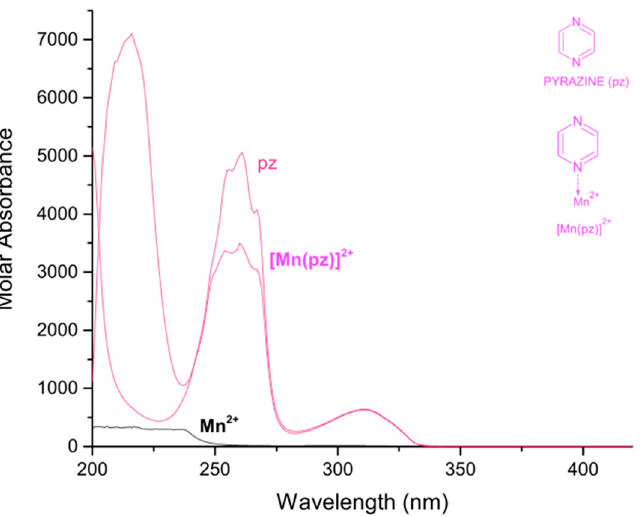
Figure 1. Calculated electronic spectrum of manganese(II)–pyrazine in methanol: pyrazine (pz), Mn 2+ and [Mn(pz)] 2+ .